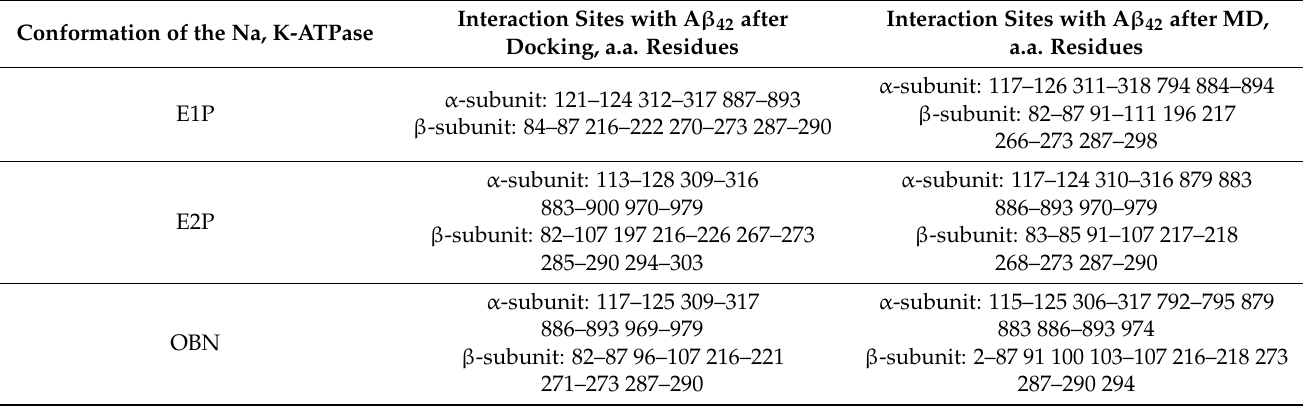
Table 1. Interaction sites of E1P, E2P and OBN conformations of Na,K-ATPase with A β 42 after docking and subsequent